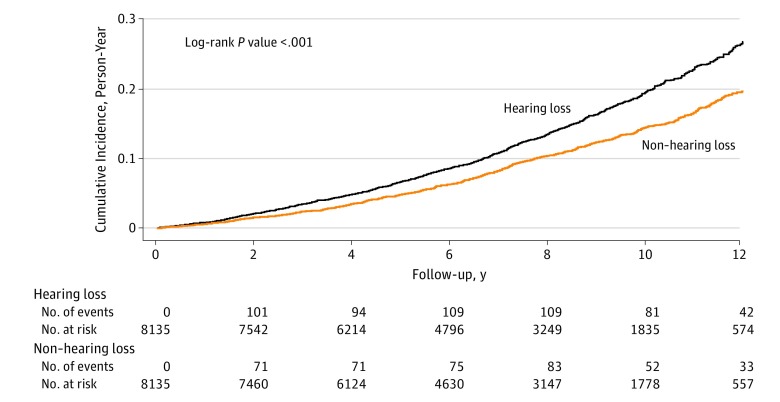
Cumulative Incidence of Dementia by Study GroupThe 8135 patients with hearing loss (HL group) were matched by sex, age, residence, and insurance premium with 8135 individuals without hearing loss (non-HL group).